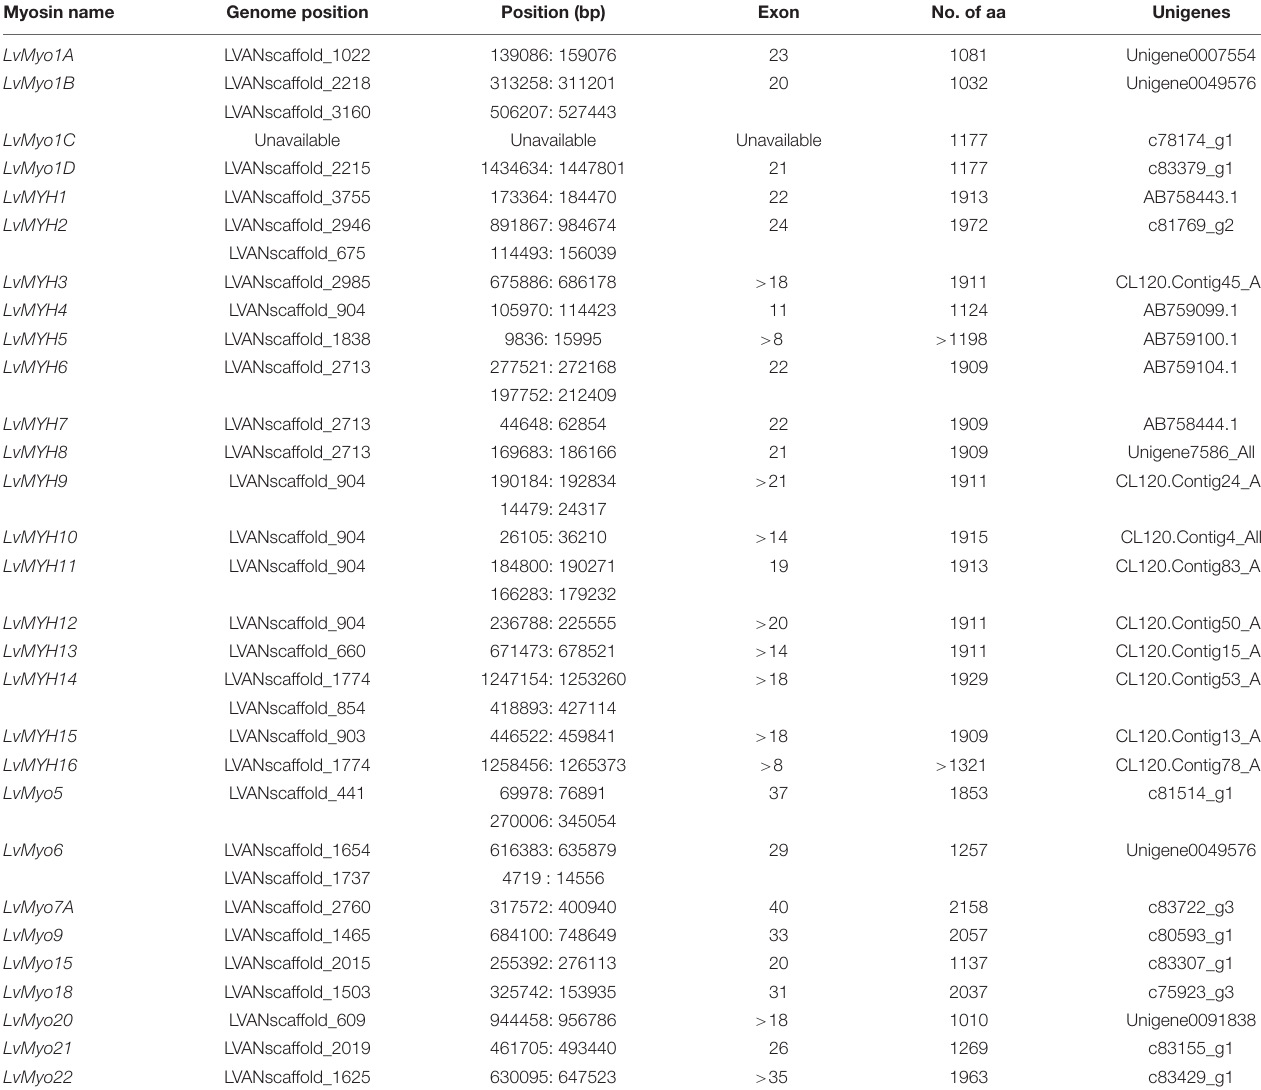
TABLE 1 | The 29 myosin genes identified from L. vannamei